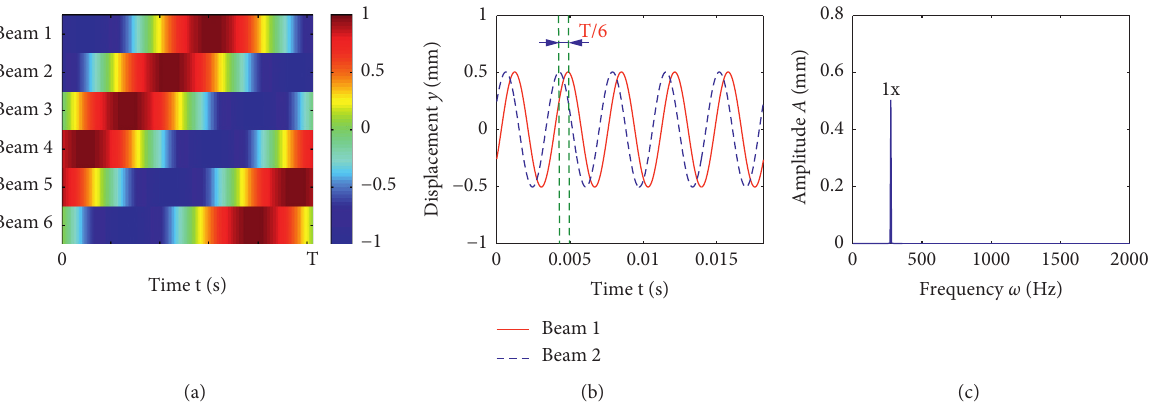
Figure 13: The response of beam tip with respect to case 1 ( Ω � 200rad/s, F � 25N, ω � 300Hz): (a) response of beam 1 to beam 6, (b) response curve of beams 1 and 2, and (c) spectrum plot of beam